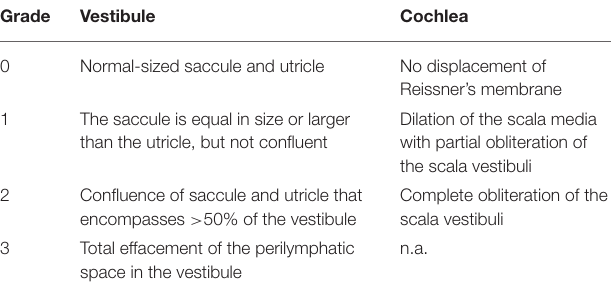
TABLE 1 | Grading of endolymphatic hydrops on 4 h-delayed Gd-enhanced 3D FLAIR